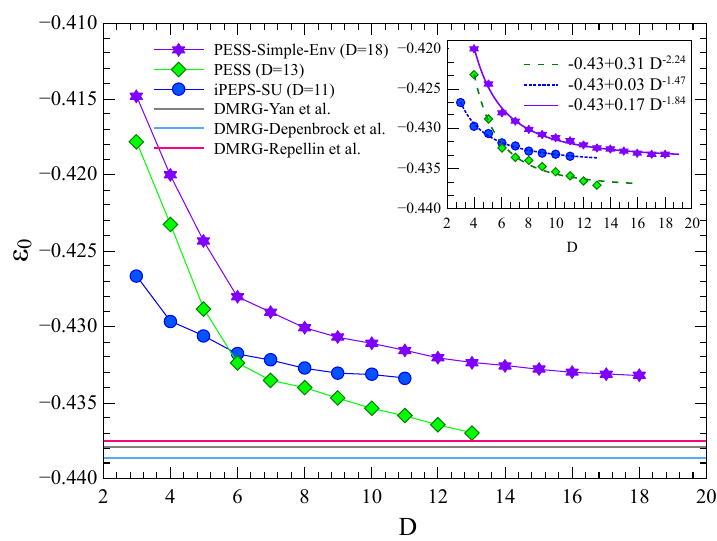
Figure 3: (Color online) Scaling of the ground-state energy, (cid:34) , with respect to bond 0 dimension D at the isotropic point, J (cid:53) / J (cid:52) = 1, for iPEPS and PESS for both full and simple calculation of environment. The inset shows the power-law extrapolation of ( D ) = (cid:34) + aD − β form. The a and β parameters the iPEPS and PESS energies with (cid:34) 0 0 for each curve are given in the plot legend. The solid lines further show the results from Refs. [ 11,25,44 ]